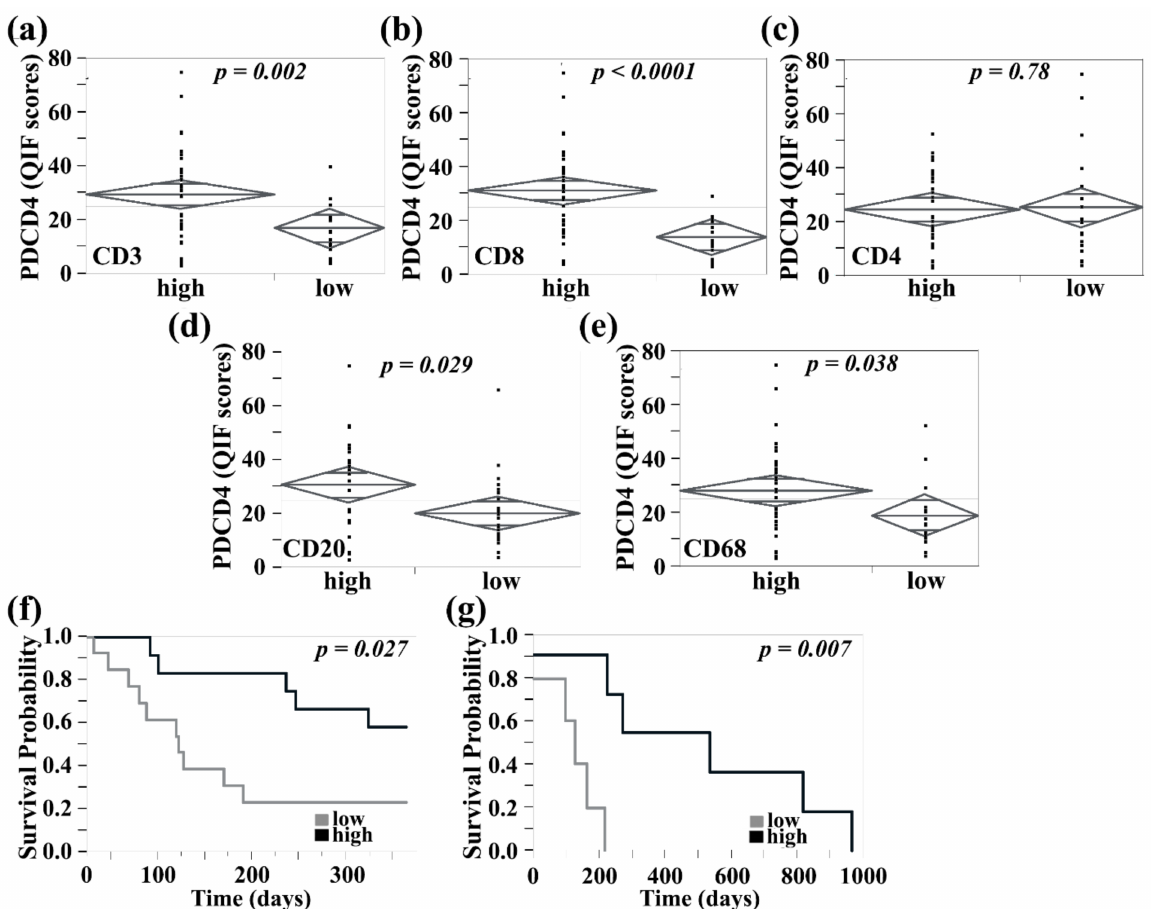
Figure 4. Analysis of PDCD4 expression in tumor infiltrating immune cells. ( a – c ) The CD3-, CD8-, and CD4-positive populations were dichotomized into two groups with high and low T cell content. ( a , b ) Cases with high CD3 and CD8 were independently found to have high stromal PDCD4 levels (non-paired t -test, p = 0.002 and p < 0.0001, respectively). ( c ) CD4 was not associated with stromal PDCD4 levels. ( d ) The CD20-positive population was dichotomized by the median into two groups with high and low B cell content. Cases with high CD20 B cell density had higher stromal PDCD4 expression (non-paired t -test, p = 0.029). ( e ) CD68-positive macrophage populations were also dichotomized into two groups with high and low macrophage content. PDCD4 expression was increased in the group with high CD68+ macrophage density (non-paired t -test, p = 0.038). ( f ) High PDCD4 expression within the total tumor compartment was associated with improved 1-year survival from the date of brain metastasis diagnosis (log-rank test, p = 0.024). ( g ) Evaluation of PDCD4 expression in intracranial CD3+ T cells shows that high PDCD4 was associated with improved brain metastasis-free survival, defined as the time from the date of stage IV diagnosis to brain metastasis diagnosis (log-rank test, p =